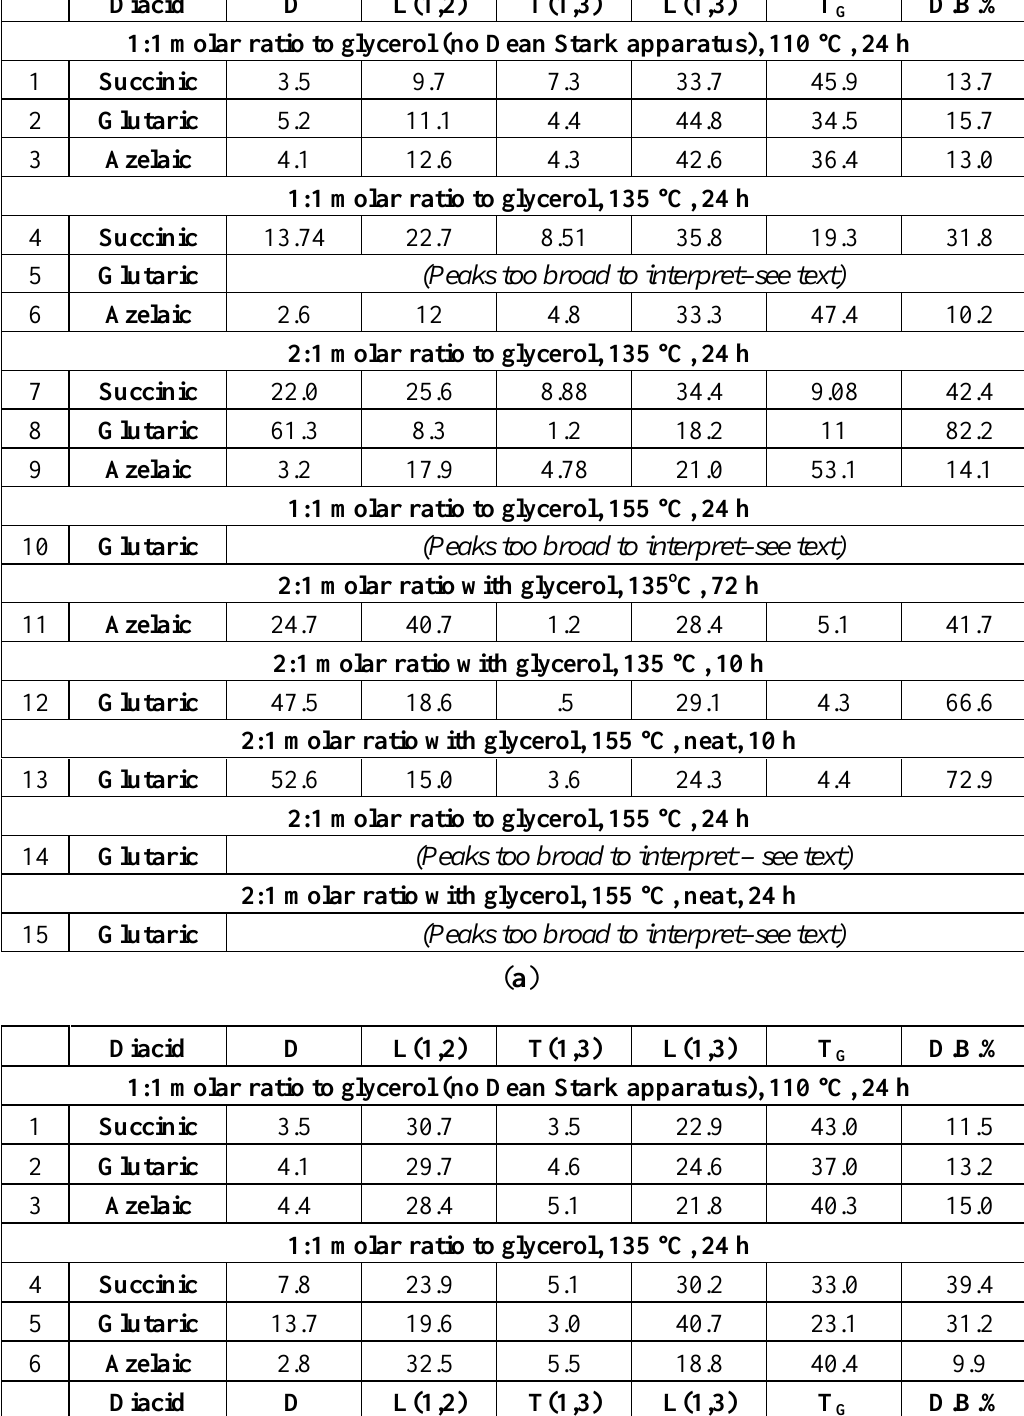
Table 2. ( a ) Relative amounts of glycerol branching (D.B.%) in oligo(glycerol-diacid)s calculated from 1 H NMR spectral data for oligo(glycerol-diacids) using Equation (1) a,b,c . ( b ) Relative amounts of glycerol branching (D.B.%) for oligo(glycerol-diacid)s calculated from 13 C NMR spectral data for oligo(glycerol-diacids) using Equation (1) a,b,c